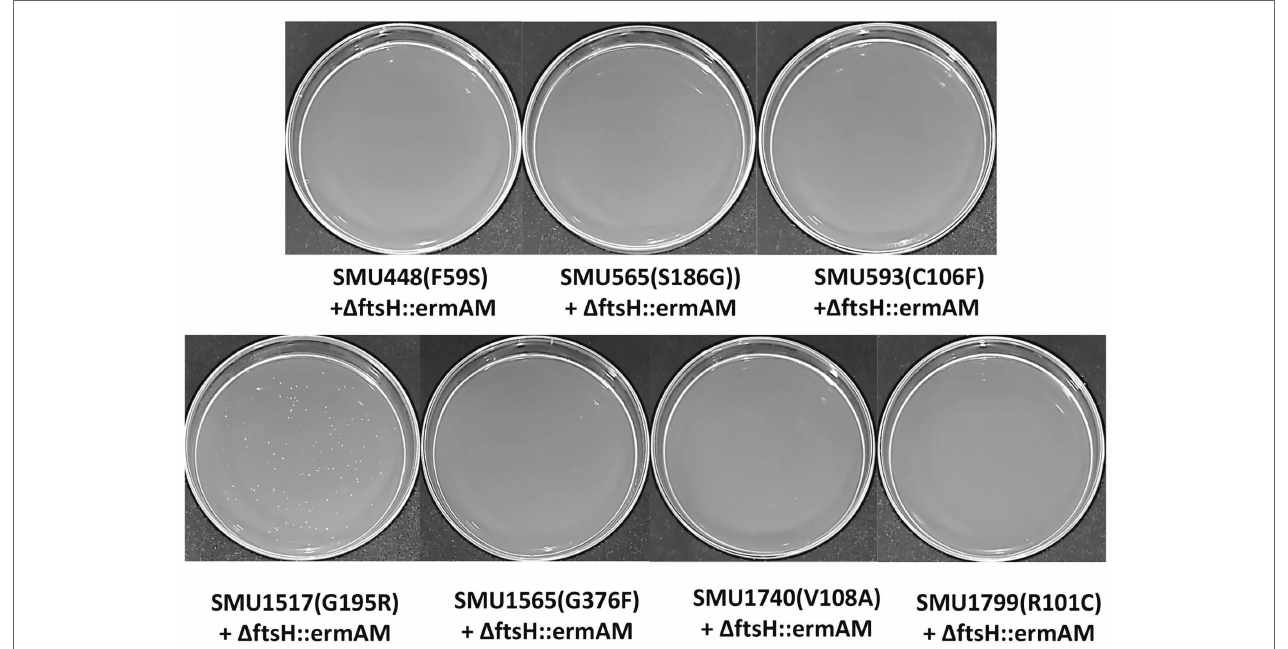
FIGURE 3 | Suppressor mutation identification. Seven DNA fragments, corresponding to the seven missense mutations identified in Table 1 , were generate by PCR amplification of strain S876 and designated as SMU448(F59S), SMU565(S186G), SMU593(C106F), SMU1517(G195R), SMU1565F(G376F), SMU1740(V108A), and SMU1799(R101C). Each of these amplicons was co-transformed into wild-type strain UA159 together with the ftsH deletion construct ∆ ftsH::ermAM. About 100 μ l of each transformation reaction were spread onto selective